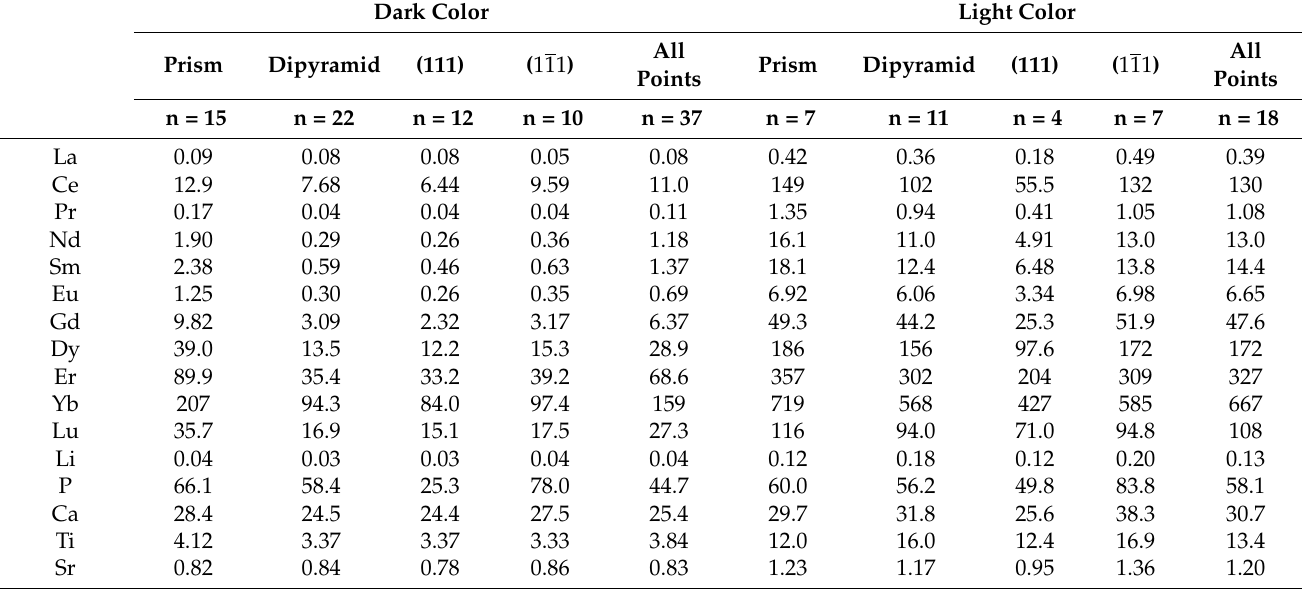
Table 1. The mean (median) values of composition (ppm) of the zircon from Ilmen Mountains feldspathic pegmatite. Dark Color Light